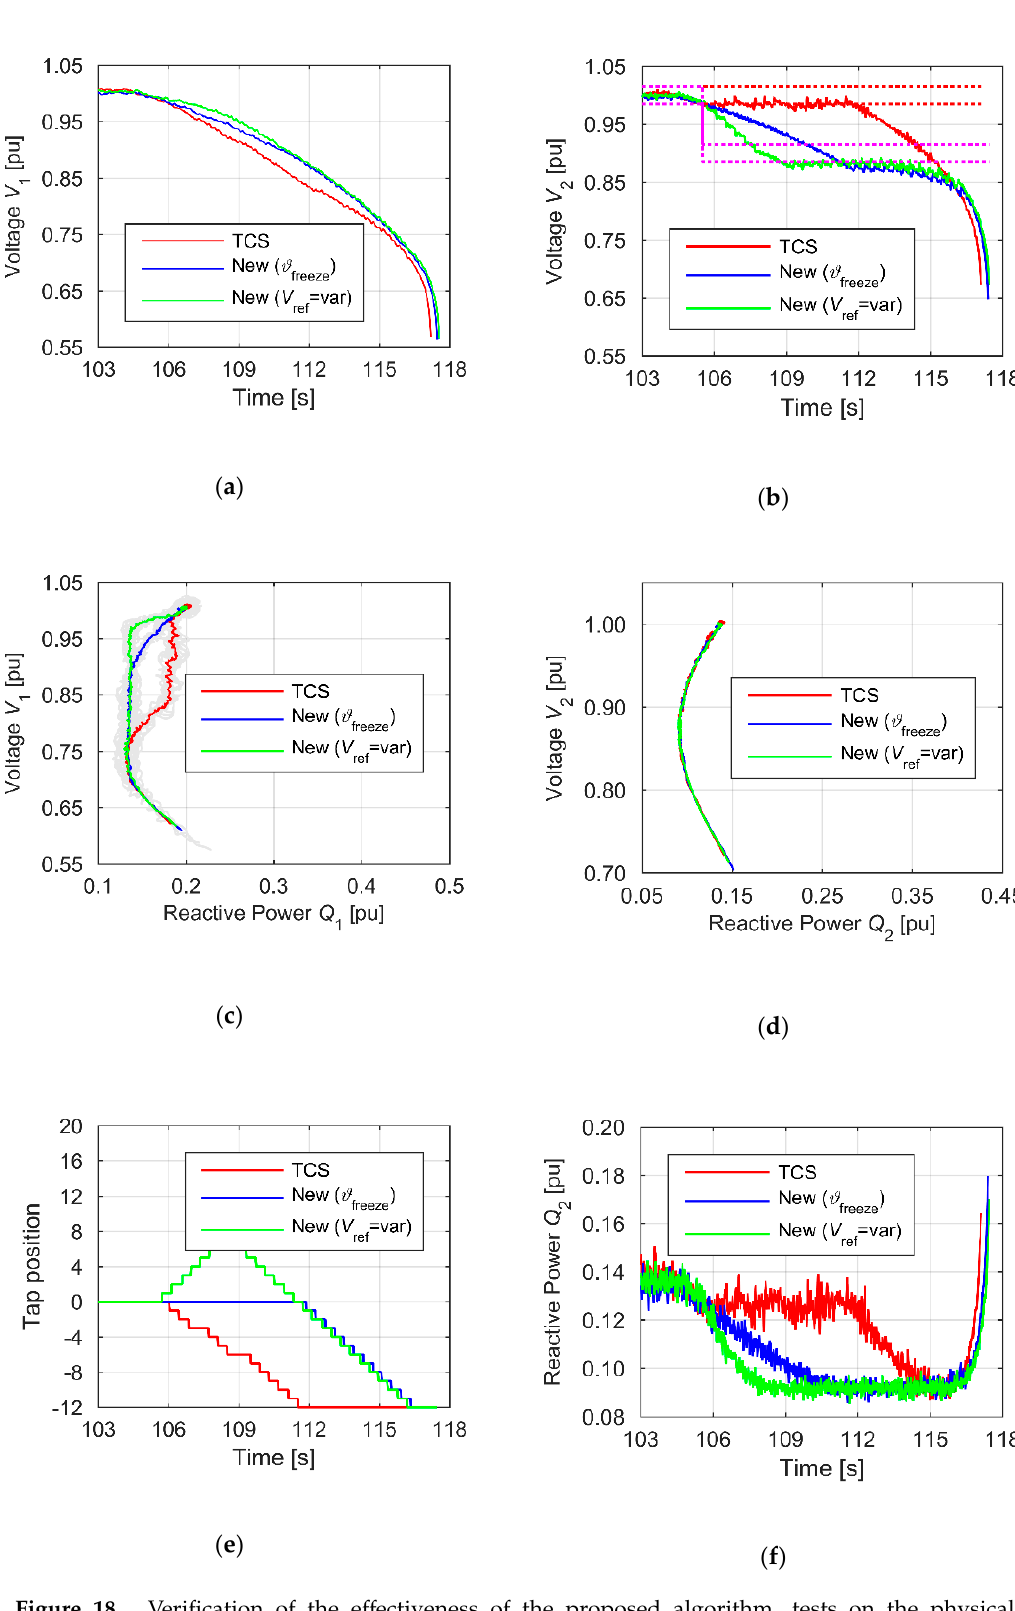
Figure 18. Verification of the effectiveness of the proposed algorithm, tests on the physical model—variant D: ( a ) voltage V 1 ; ( b ) voltage V 2 ; ( c ) characteristics V 1 = f( Q 1 ); ( d ) characteristics V 2 = f( Q 2 ); ( e ) tap position; ( f ) reactive power Q 2 .